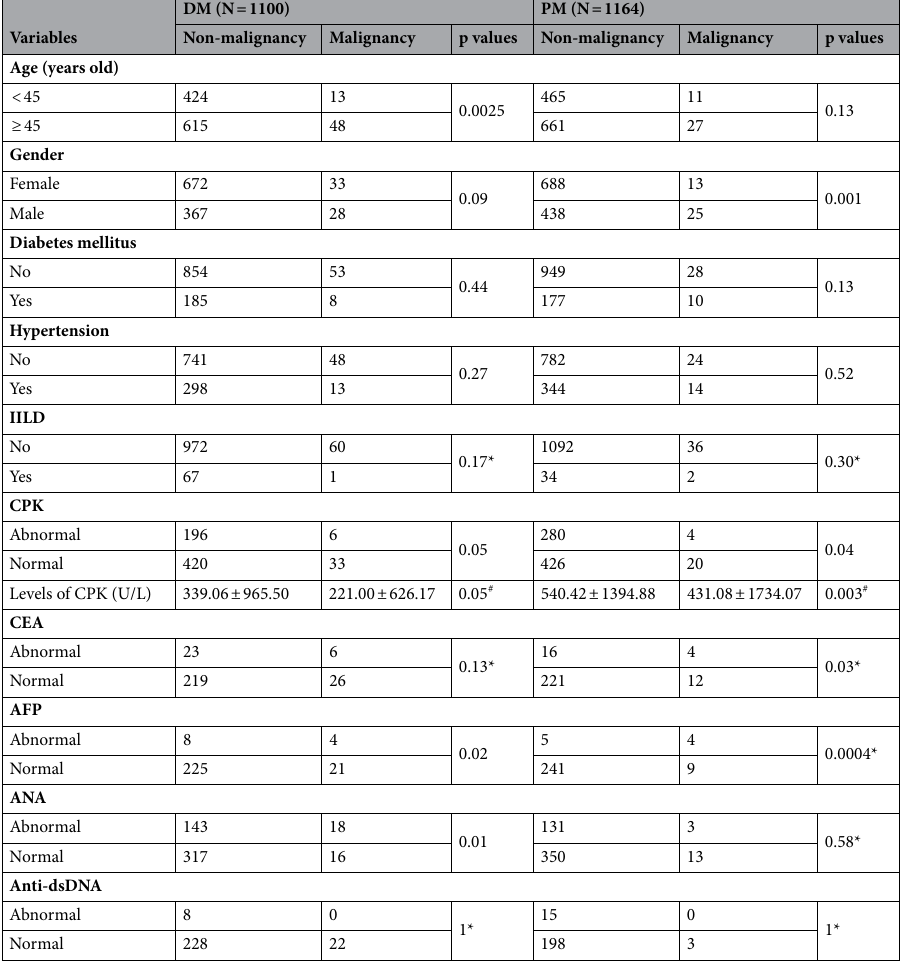
Table 3. Statistic analysis of risk factors associated with PM/DM with and without malignancy. DM dermatomyositis, PM polymyositis, II L D idiopathic interstitial lung disease, CPK creatine phosphokinase,